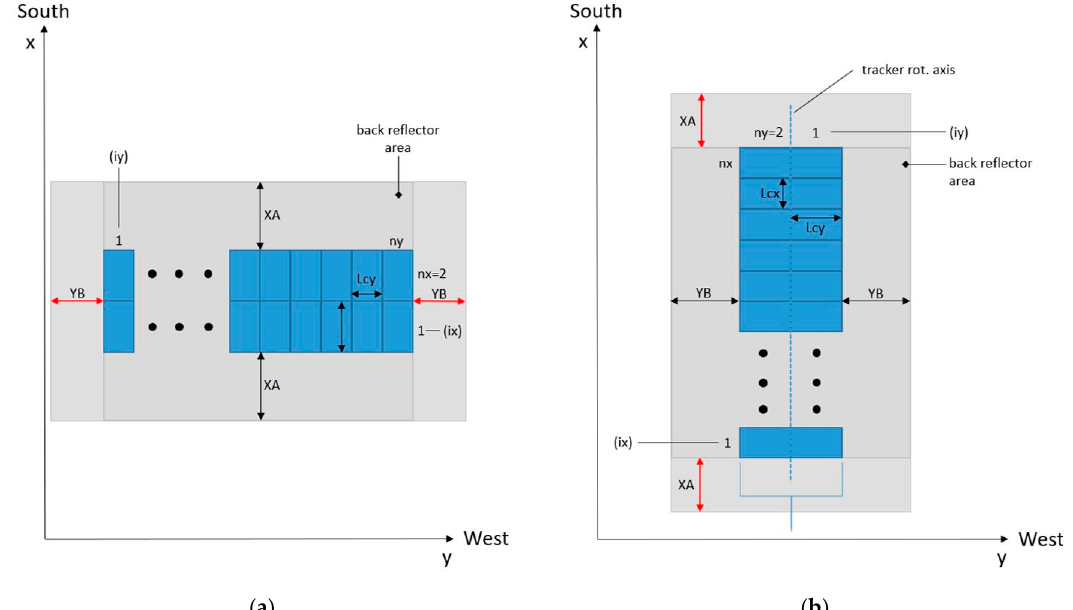
Figure 1. Module placement geometry for the two cases considered in this study: ( a ) fixed photovoltaic (PV) string, with modules oriented towards south and tilted of an angle equal to the latitude of the considered location of the northern terrestrial hemisphere; ( b ) PV string with uniaxial horizontal solar tracker. XA and YB are the parameters identifying the dimensions of the ground zone (acting as back reflector for the bifacial PV devices) considered for the calculations. nx represents the total number of PV modules along the x direction, i.e., the north–south direction (equal to 2 for the fixed string, 15 or 30 for the string with tracker), while ny indicates the total number of PV modules along the y direction, i.e., the east–west direction (equal to 15 or 30 for the fixed string, 2 for the string with tracker). For the main purpose of studying the perimeter effects, in this work, YB was varied (by assuming for it the values 0, 5, 10, or 20 m, alternately) with XA constant (equal to 5 m) for the fixed string; instead, for the PV string with tracker, XA was varied (by assuming for it the values 0, 5, 10, or 20 m, alternately) with YB constant (equal to 5 m).